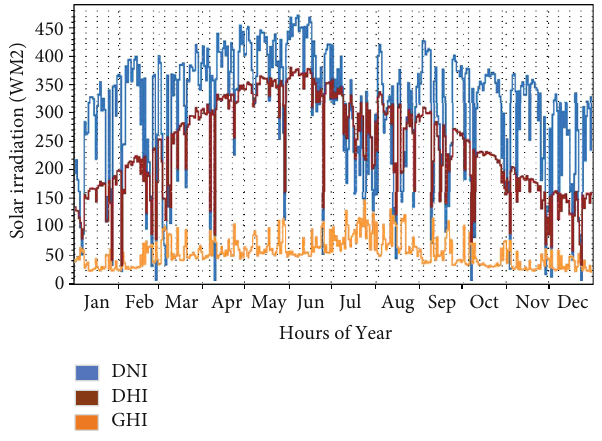
Figure 16: Hourly GHI, DNI, and DHI during a